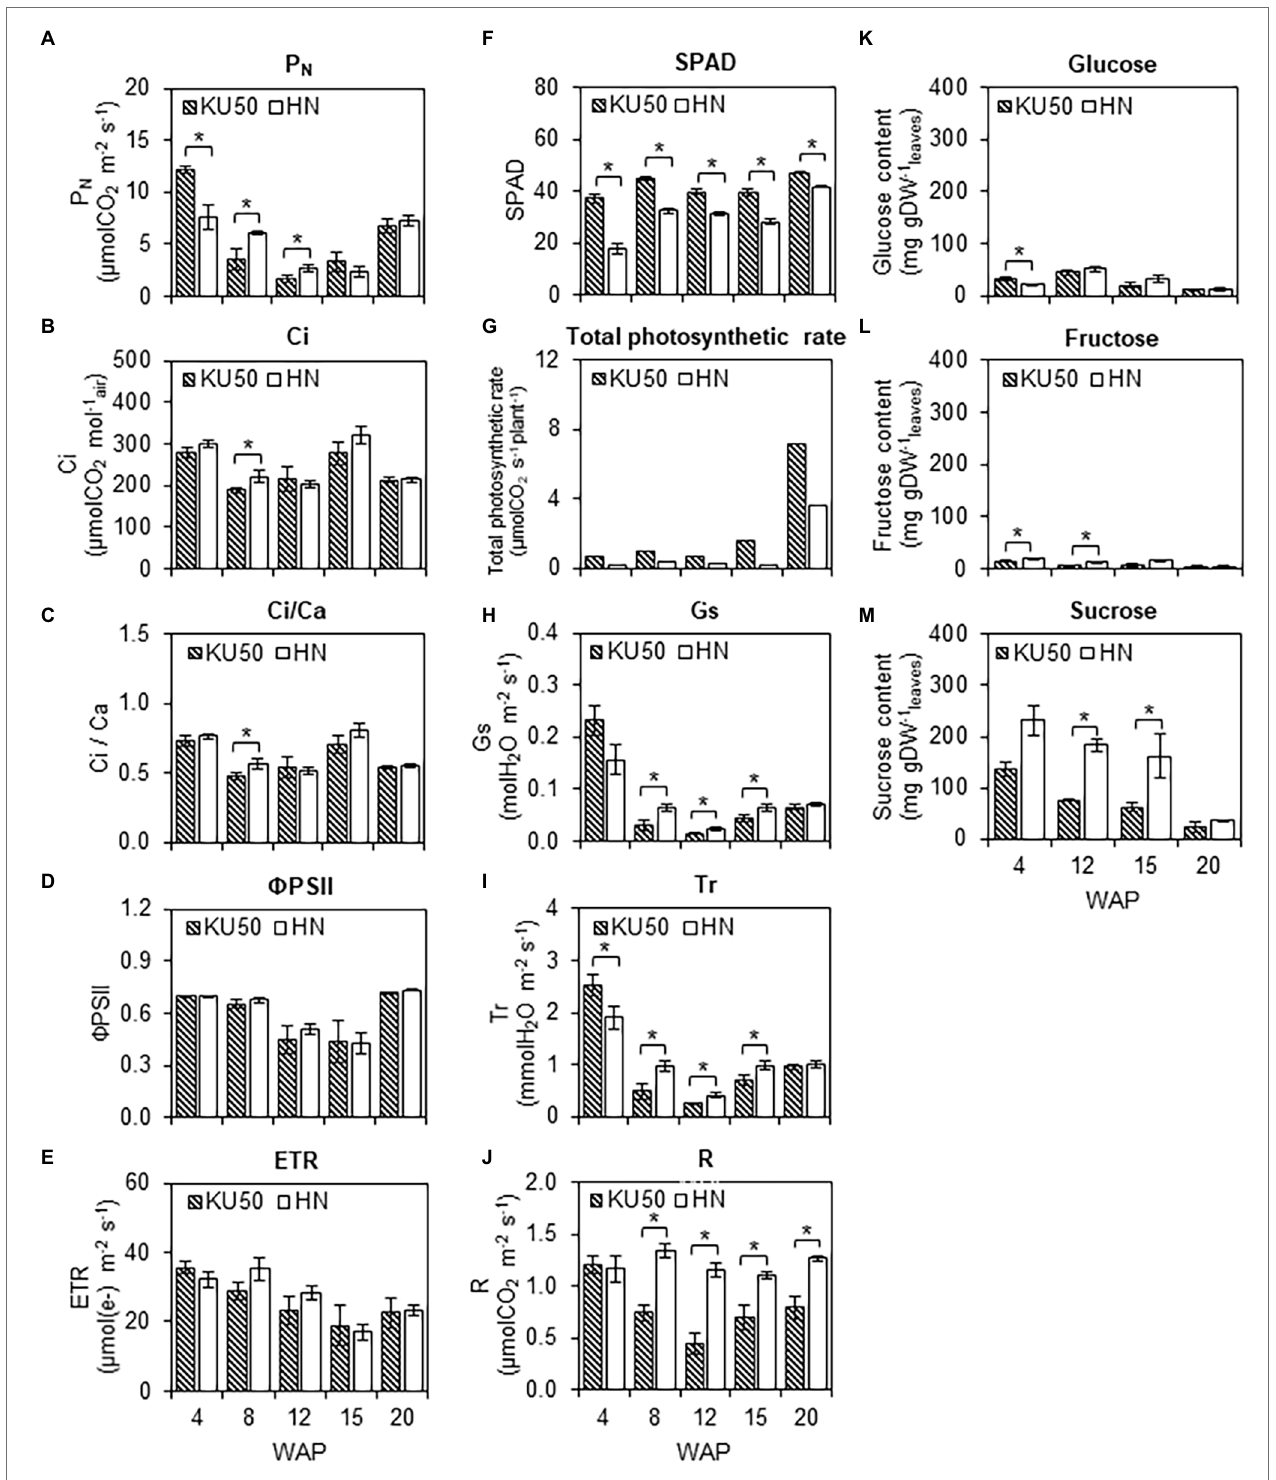
FIGURE 1 | Photosynthesis capability and carbon assimilation of Kasetsart 50 (KU50) and Hanatee (HN) cassava varieties at various developmental stages. Leaf gas exchange and chlorophyll fluorescent parameters, including the (A) photosynthetic rate (P N ), (B) intercellular CO 2 concentration (Ci), (C) the ratio between intercellular and ambient CO 2 concentrations (Ci/Ca), (D) effective quantum yield of photosystem II photochemistry ( Φ PSII), (E) electron transport rate (ETR), (F) leaf greenness index (SPAD), (G) total photosynthetic rate, (H) stomatal conductance (Gs), (I) transpiration rate (Tr), (J) respiration rate (R), as well as soluble sugar contents, including (K) glucose, (L) fructose, and (M) sucrose, were measured from a fully expanded mature leaf at midday. Each result is the mean ± SE value obtained from five biological replicates. Statistical significance, based on a one-sided Student’s t -test, is denoted by * p ≤ 0.05. The total photosynthetic rate was calculated by multiplying the average P N value by the average total number of attached mature leaves for each variety. WAP, week after